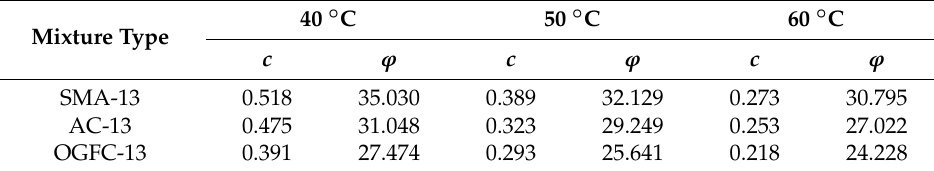
Table 8. Strength parameters of asphalt mixtures by linear failure envelope.